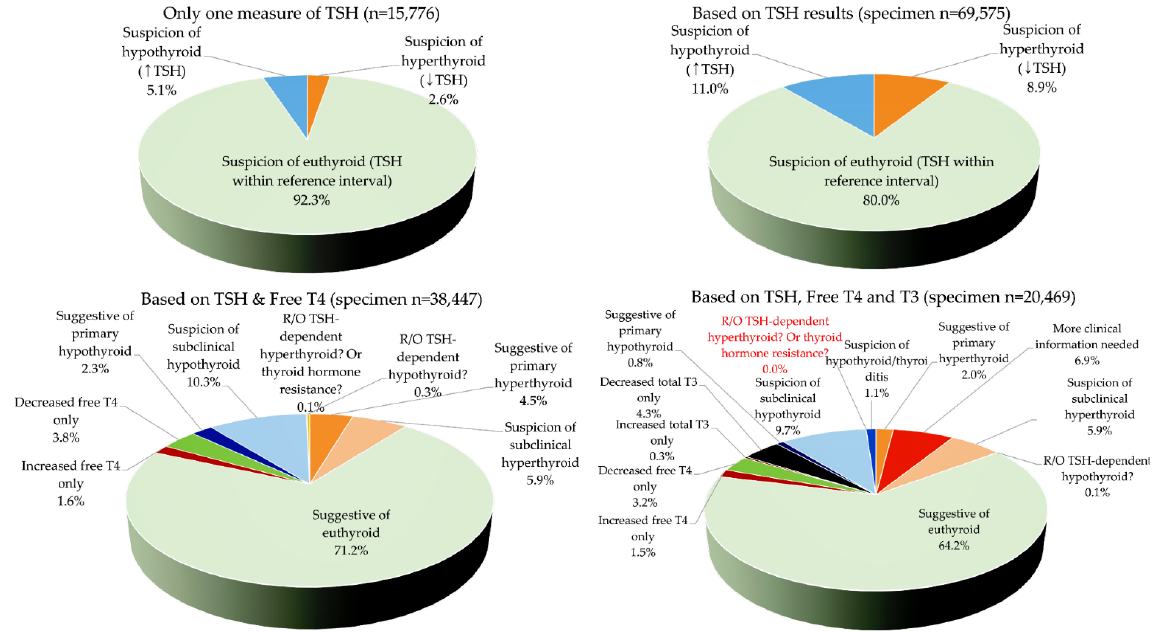
Figure 1. Prevalence of specimen thyroid function test (TFT) results. Interpretation of results among 15,776 specimens from 15,776 patients who had only one TSH measurement ( left upper ), interpretation using TSH results only among all 69,575 specimens ( right upper ), interpretation using TSH and free T4 among 38,447 specimens tested for both TSH and free T4 ( left lower ), and interpretation using TSH, free T4, and total T3 among 20,469 specimens tested for all three TFTs ( right lower ). Specimens needing more clinical information included possible cases for patients being treated for thyroidal illness, nonthyroidal illness, subacute thyroiditis, thyroxine protein- binding abnormalities, possible interference, etc. Schemes follow the same formatting. ( ↑ ) represents ‘increased’ and ( ↓ ) represents ‘decreased.’